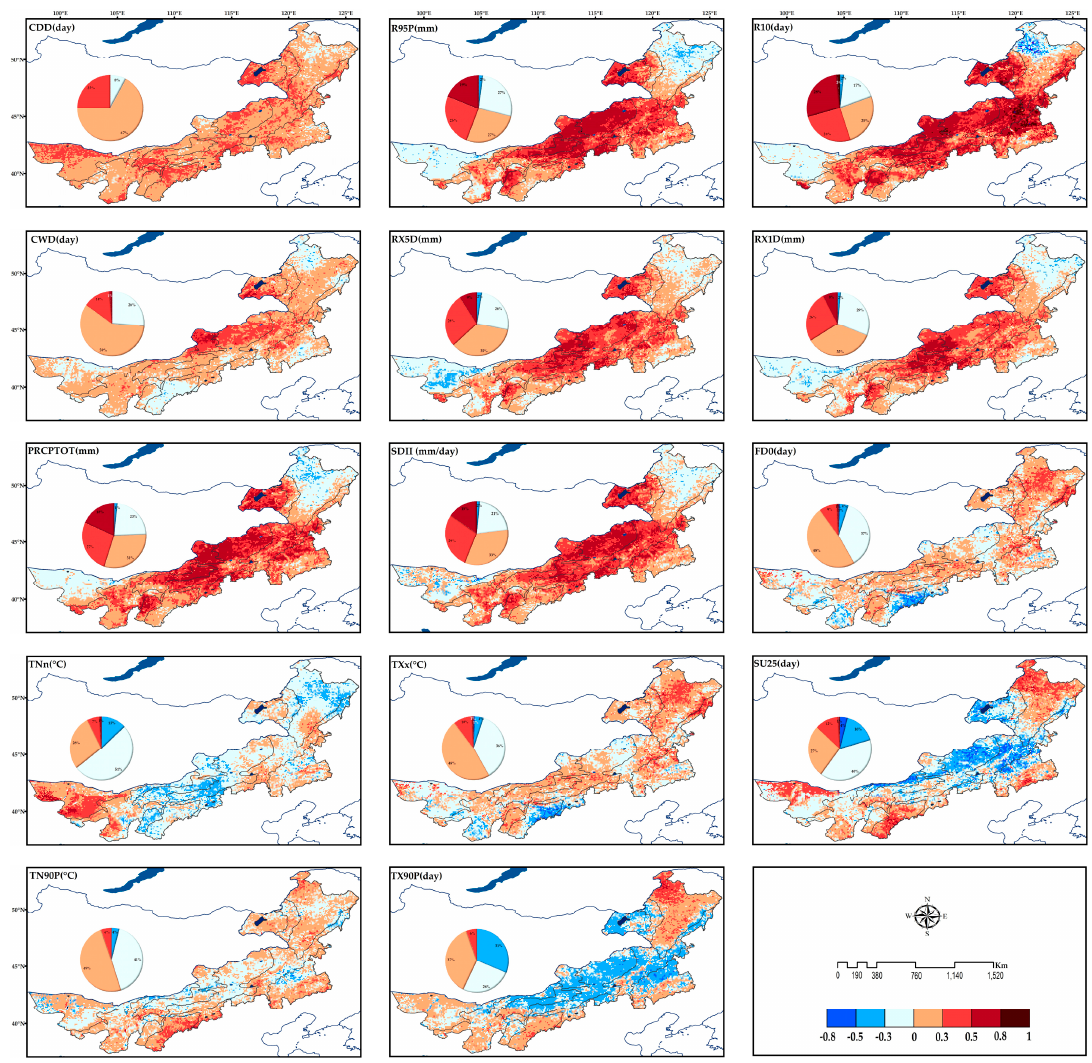
Figure 4. Correlation between mean NDVI and extreme climate indices in different vegetation types during 1982–2015.